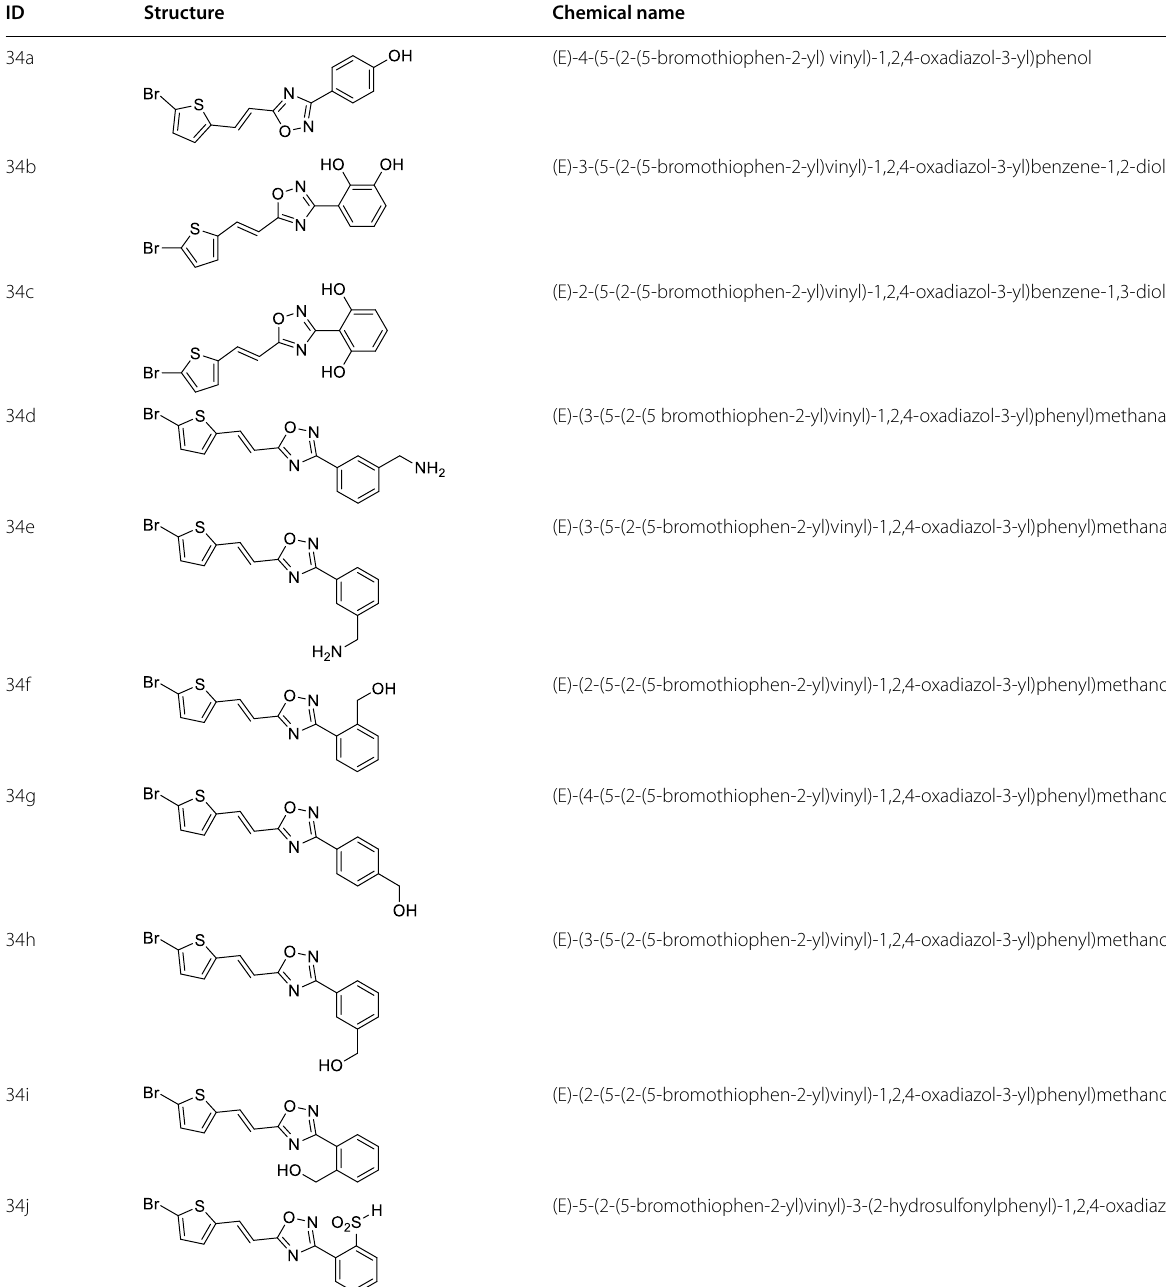
Table 1 2D Structures of the designed 1, 2, 4-oxadiazole derivatives from the